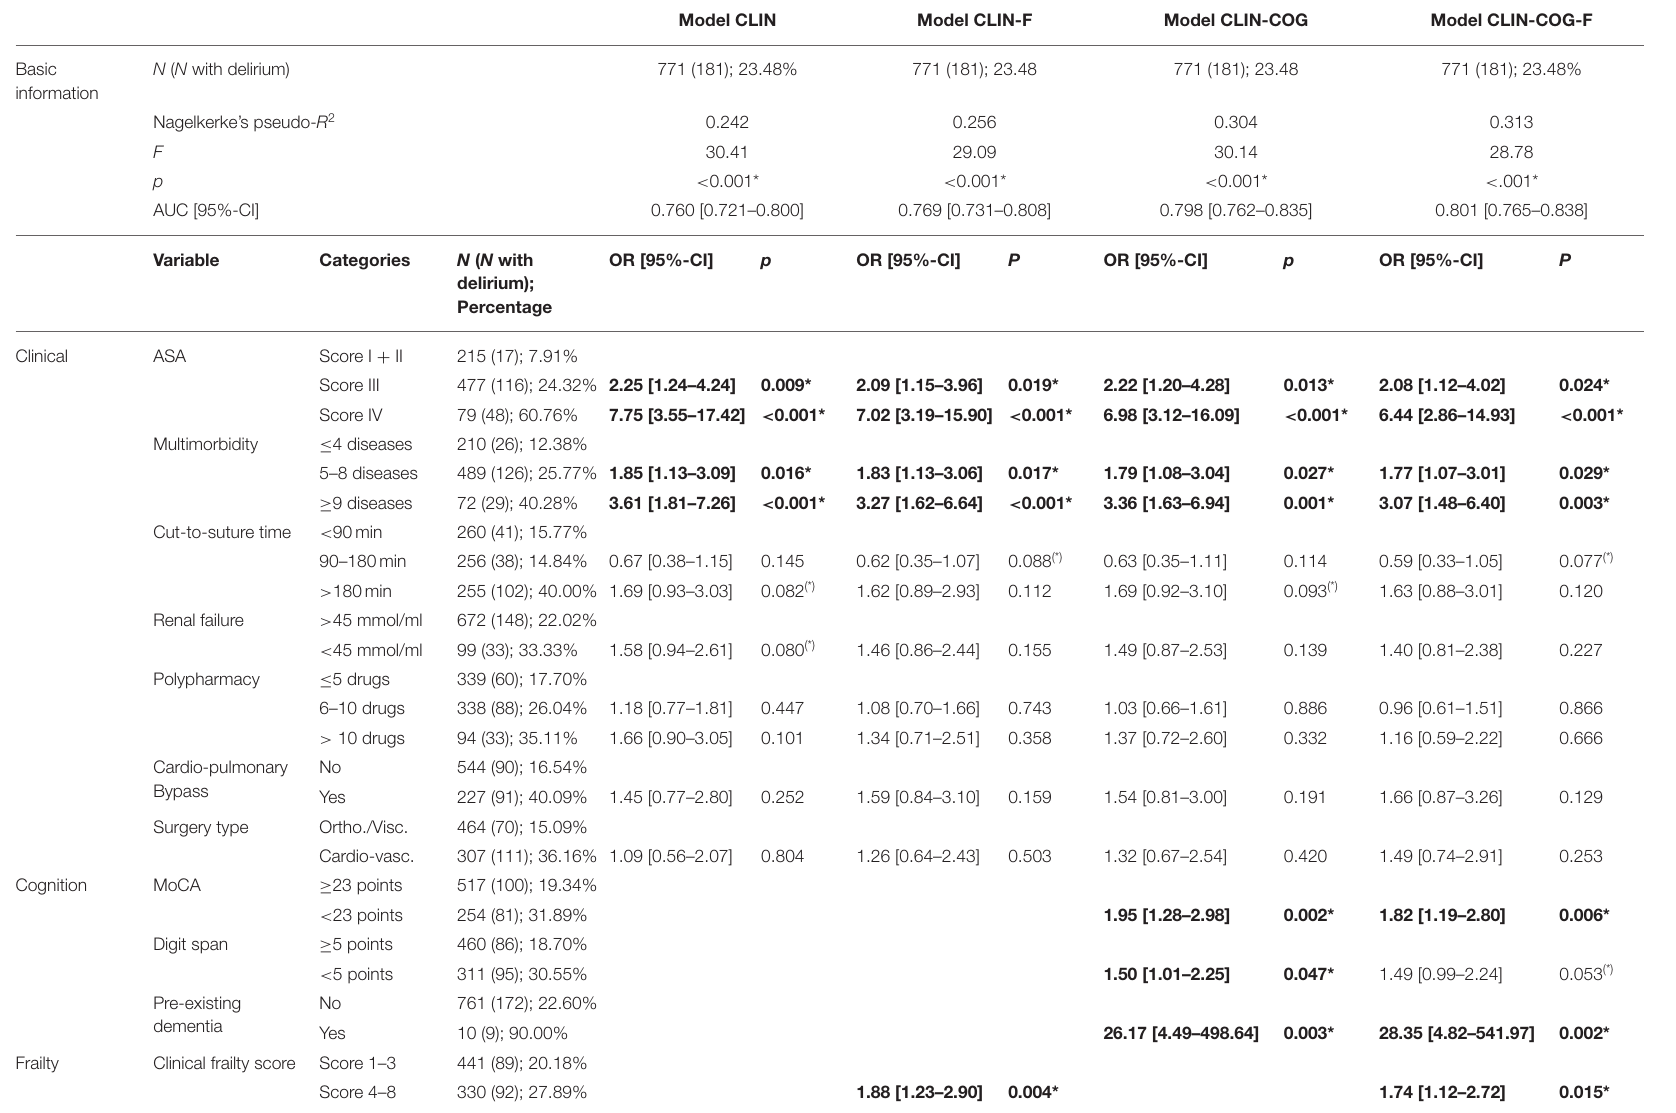
Results from multivariate logistic regression analysis comparing four possible models with higher economical practicability. All the data were grouped into the categories stated. To ensure the possibility of statistical comparison of all models, only the patients were included, for whom data in all the models were available. Statistically significant tests results are highlighted in bold type, significant p-values are marked with * , and p-values at a significance level of .05 to 0.1 are marked with ( *